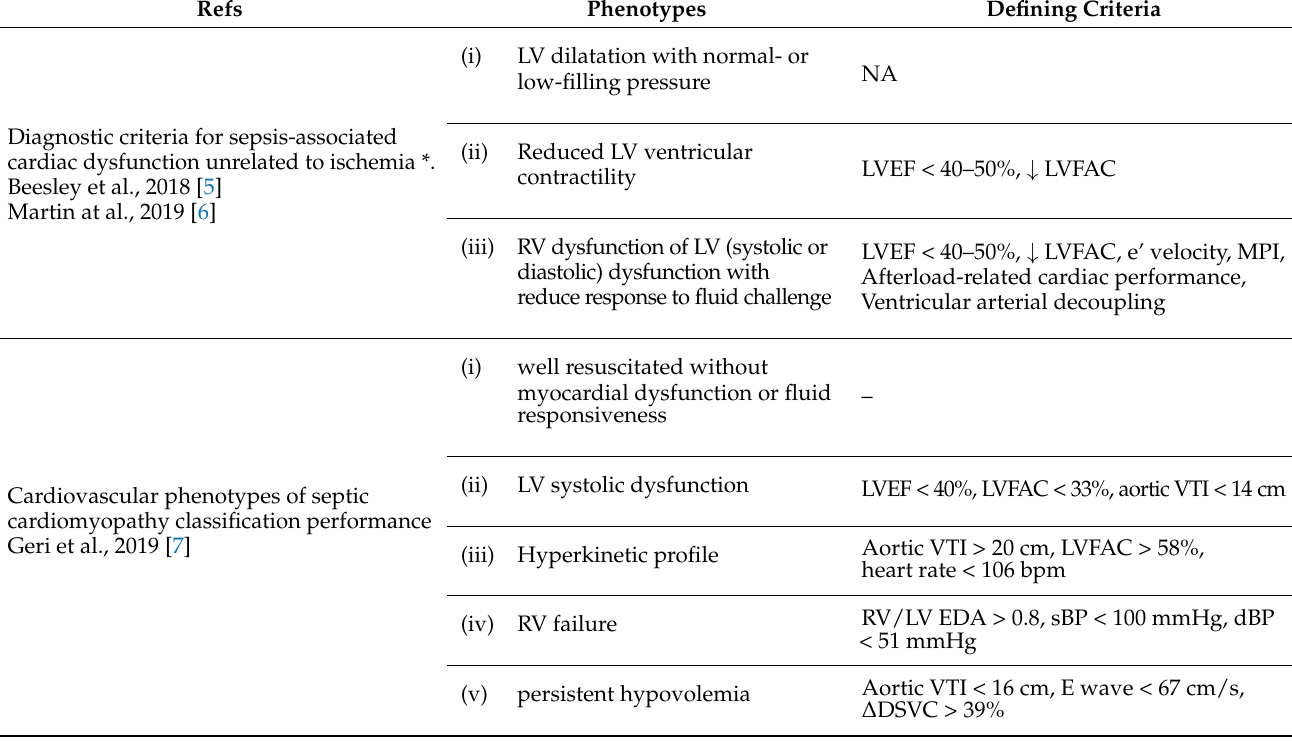
Table 1. Definition of septic